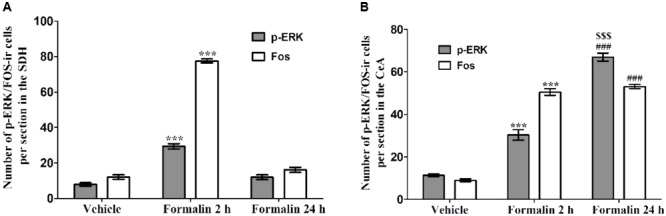
The expressions of p-ERK and Fos in the ipsilateral SDH and contralateral CeA after formalin injection. The expressions of p-ERK and Fos in the ipsilateral SDH after formalin injection (A). The expressions of p-ERK and Fos in the contralateral CeA after formalin injection (B). ∗∗∗P < 0.001, formalin injection 2 h group compared with vehicle group; ###P < 0.001, formalin injection 24 h group compared with vehicle group; $$$P < 0.001, formalin injection 24 h group compared with formalin injection 2 h group; one-way ANOVA, Turkey’s post hoc test, n = 18 sections in each group.